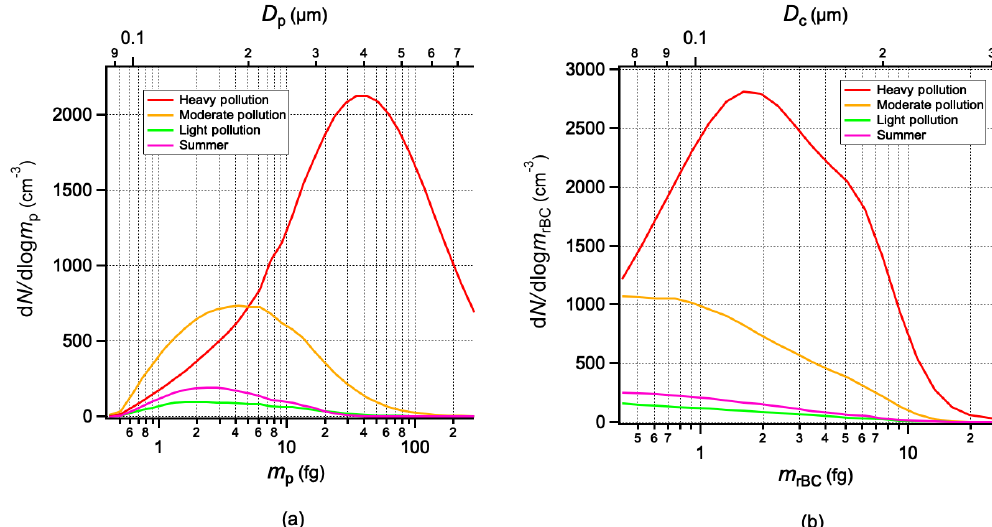
Figure 5. CPMA–SP2 m p number distribution (a) and m rBC number distribution (b) under different pollution conditions.